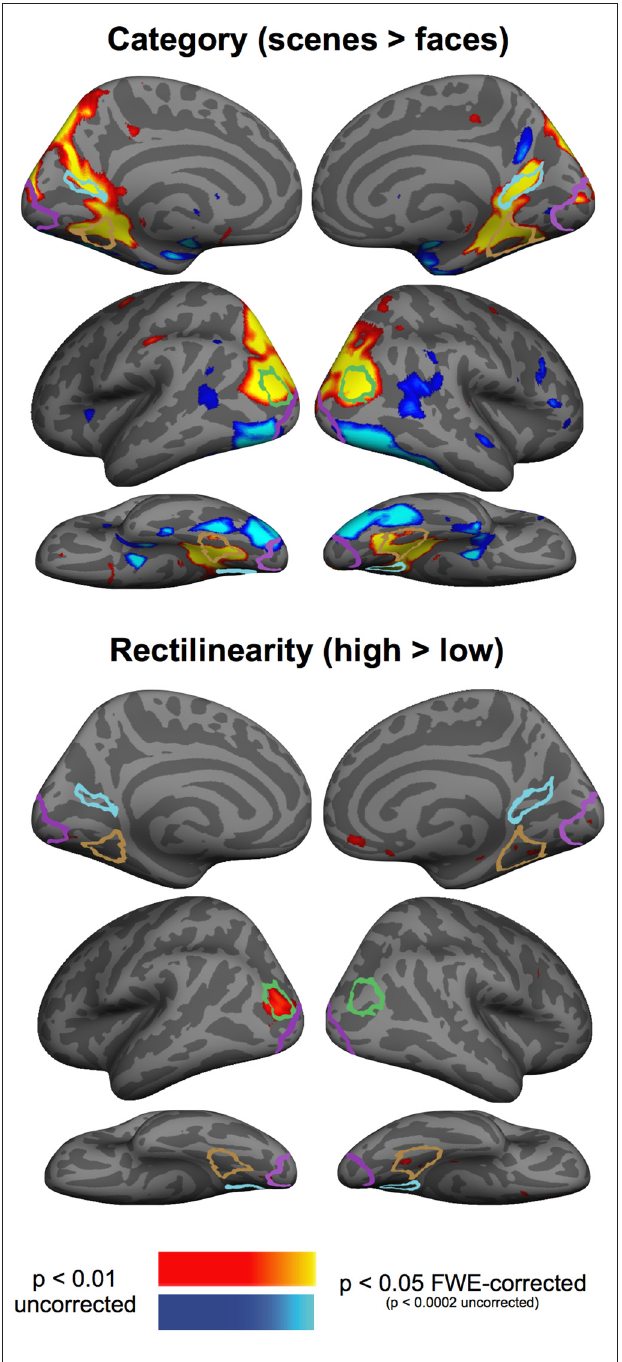
FIGURE 5 | Group-averaged contrast maps of the effect of category (scenes > faces contrast) and rectilinearity (high-rectilinearity > low- rectilinearity contrast). Outlines of the group-defined parcels are shown for the PPA in brown, RSC in light blue, OPA in green, and EVC in purple.